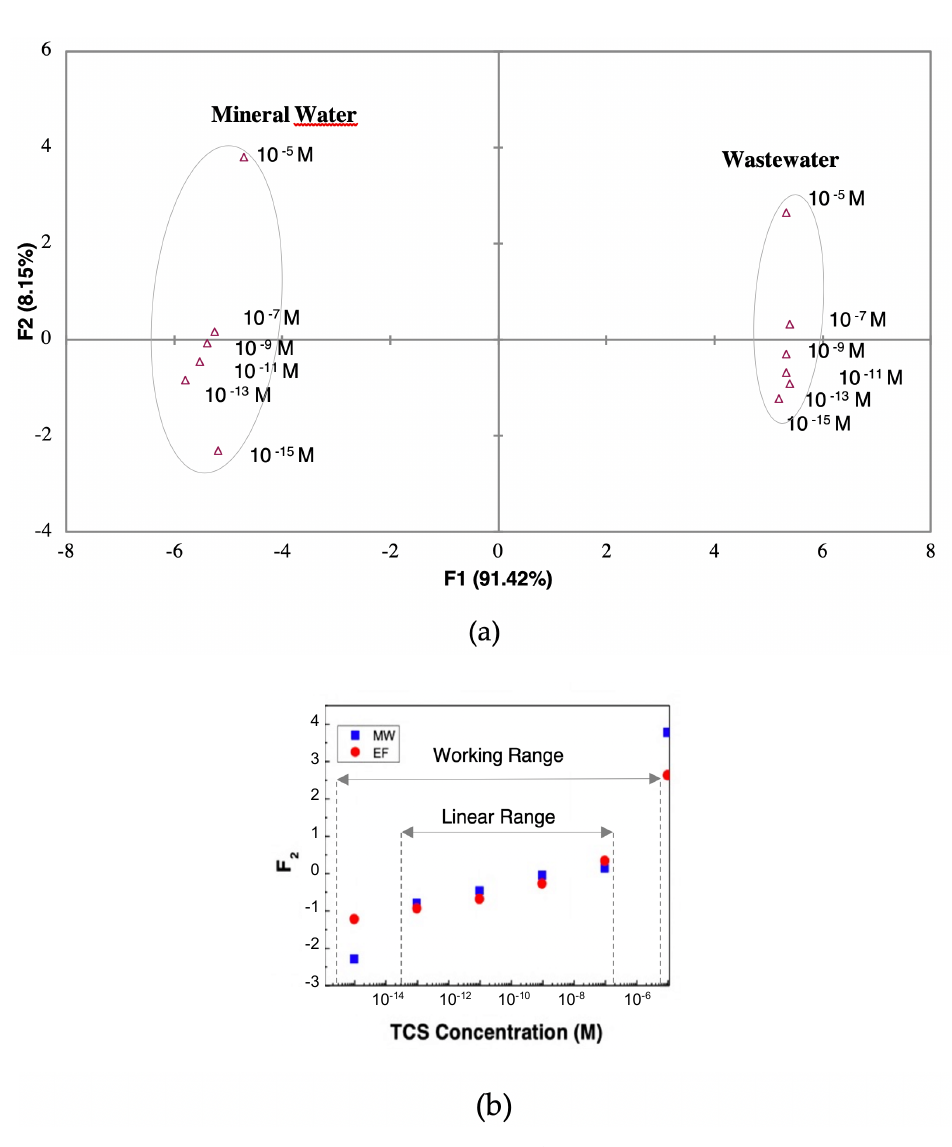
Figure 8. ( a ) PCA plot of TCS concentrations (10 − 5 –10 − 15 M) distinguished the gold IDE sensor for MW and the (PEI / PSS) 5 sensor for EF and ( b ) ((a) PCA data) principal components F2 factor scores as a function of TCS concentrations for the gold IDE sensor in MW and the (PEI / PSS) 5 sensor in EF.